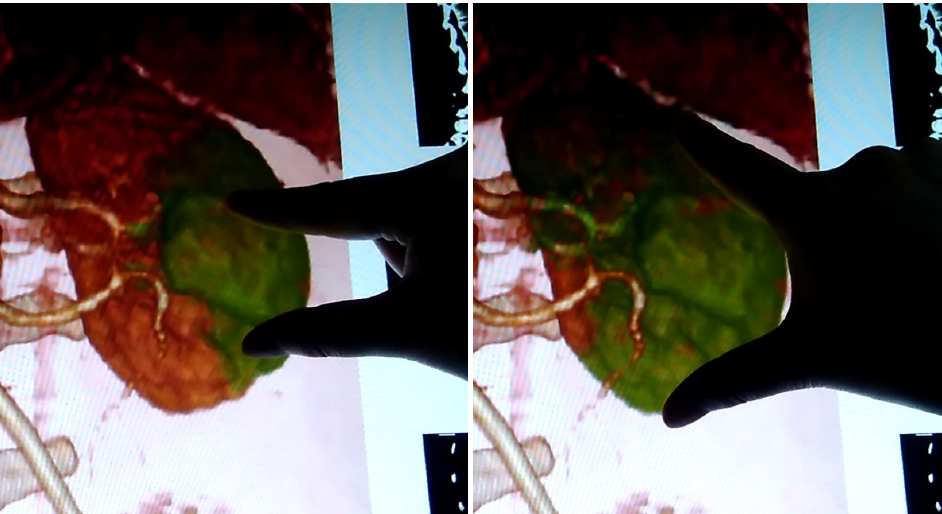
Figure 4. A mask is rasterized on the volume data to depict the selection of a handle. In the two snapshots, the extent indicated with the fingers is mapped to the